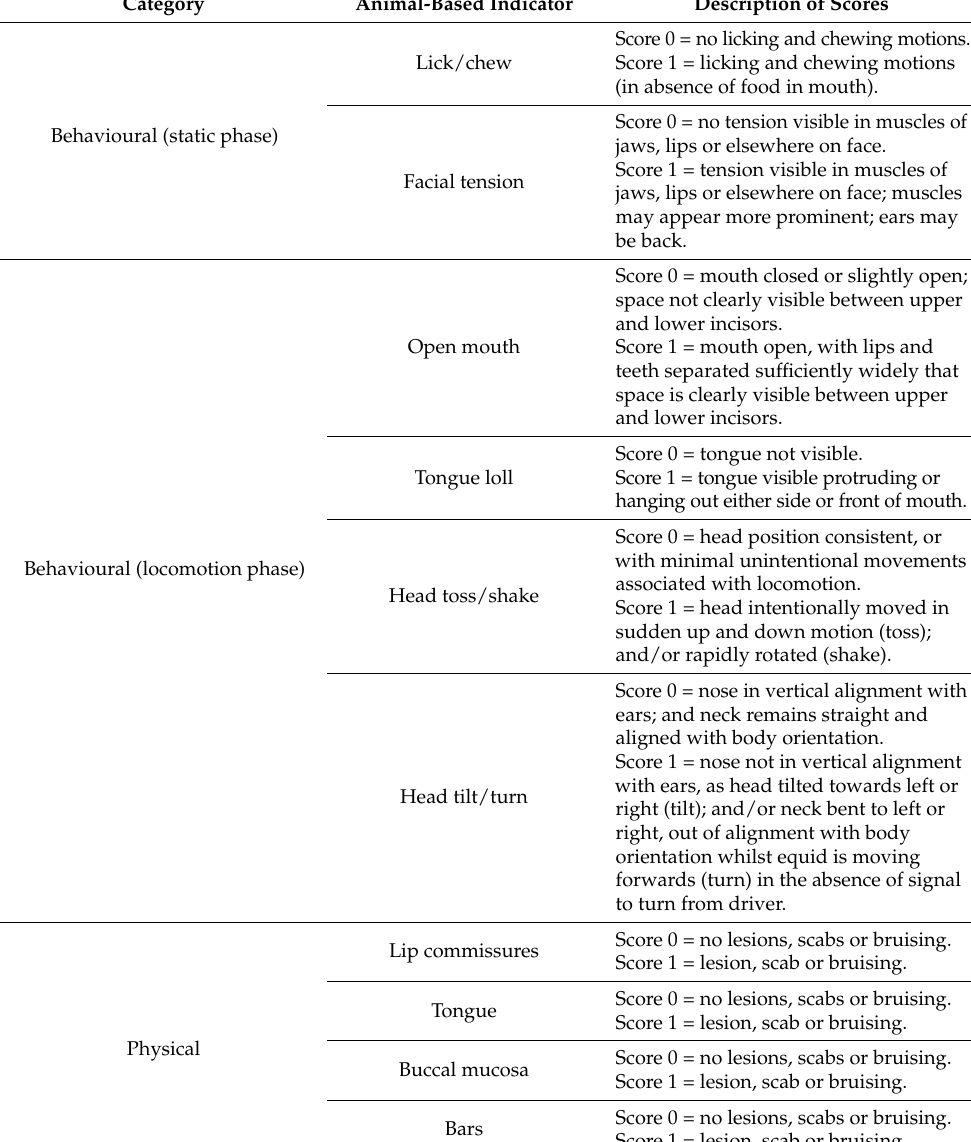
Table 2. Animal-based indicators for monitoring effects of new bit prototypes. Category Animal-Based Indicator Description of Scores